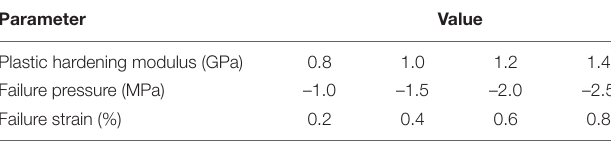
TABLE 3 | Parameters for simulation analysis of sea ice effects.